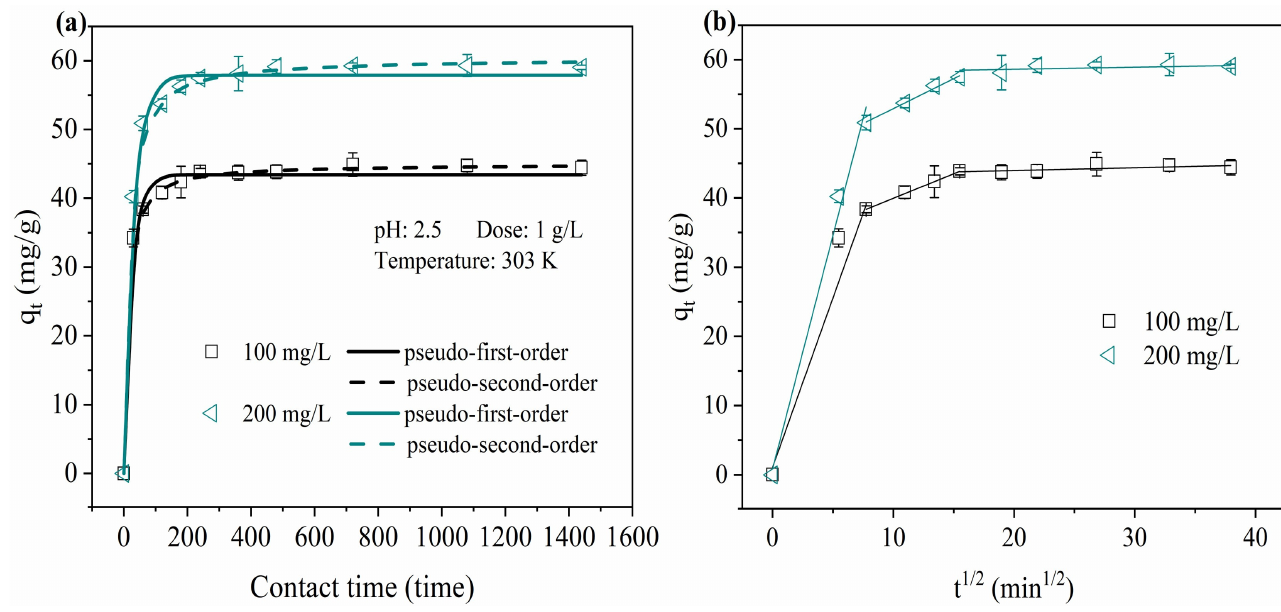
Figure 3. Effect of solution pH value on Fe (III) ( a ) removal efficiency and ( b ) the point of zero charge of PYCS.